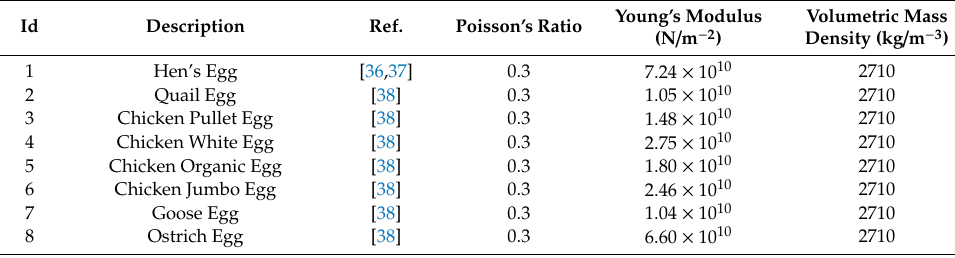
Table A9. Material properties of the avian egg thin